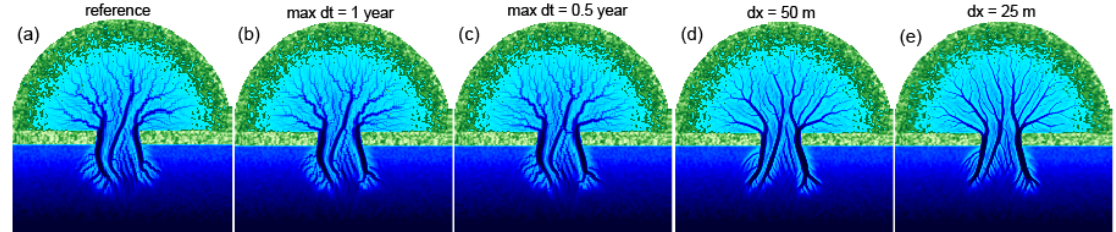
Figure 7. Sensitivity analysis of CM2D with respect to spatial and temporal resolution. All simulations are compared at year 500 (Figure 5e). ( a ) Reference simulation with a spatial resolution of 100 m and maximum time step of 2 years; ( b , c ) Maximum time step equal to 1 and 0.5 years; ( d , e ) Spatial resolution equal to 50 and 25 m.